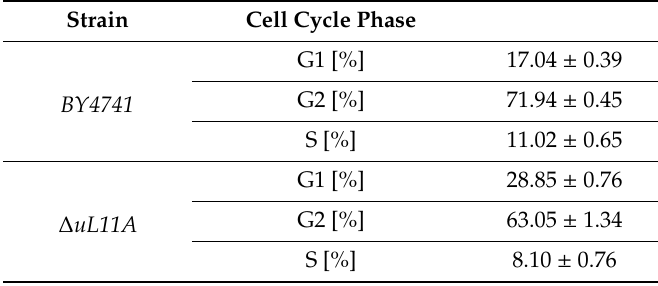
Table 1. Cell cycle analysis in the yeast mutants. The results are shown as means ± SD (n =